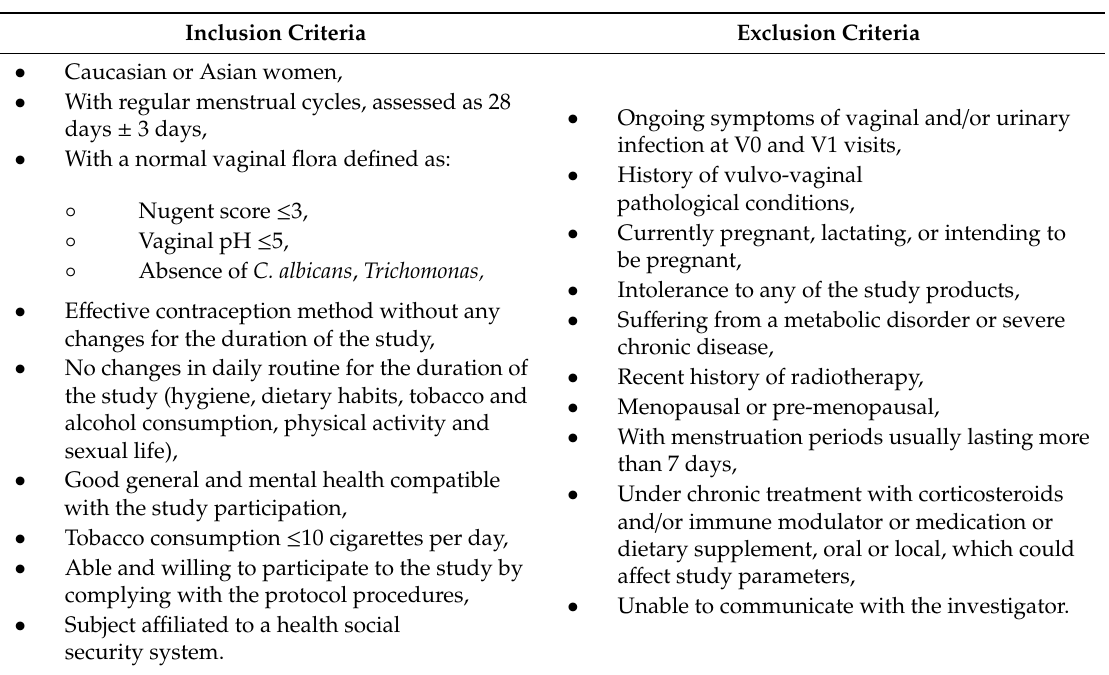
Table 1. Inclusion and Exclusion Criteria as Defined in the Study